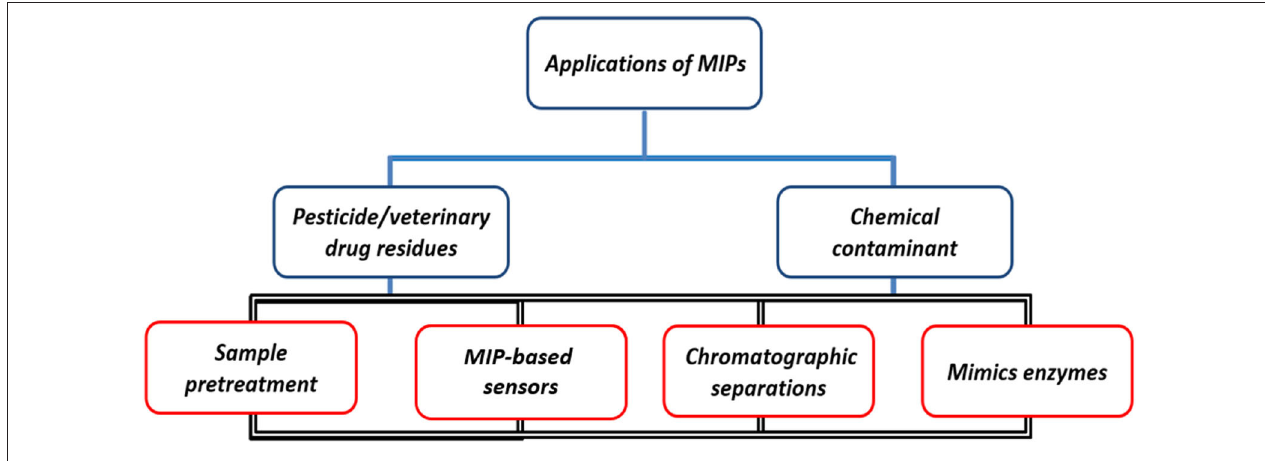
FIGURE 10 | Application of MIPs in various fields.